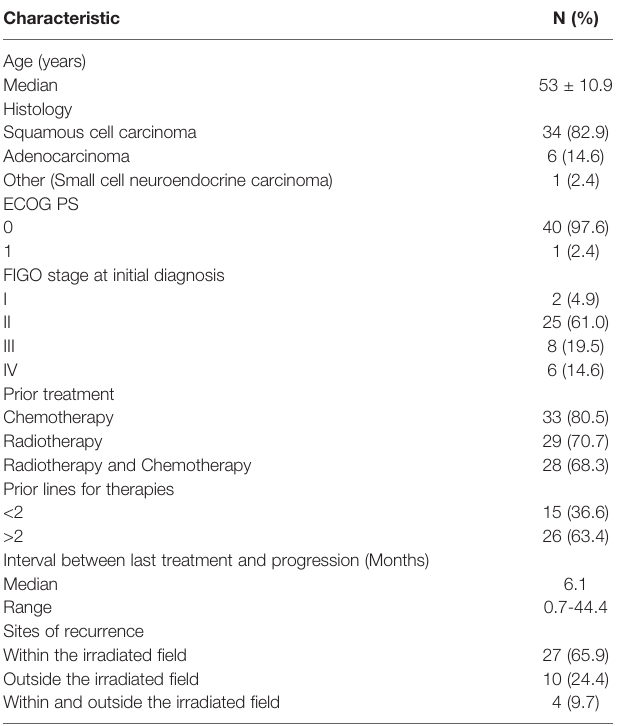
events (AEs) are listed in Table 4 . All patients experienced AEs. TABLE 1 | Baseline patient